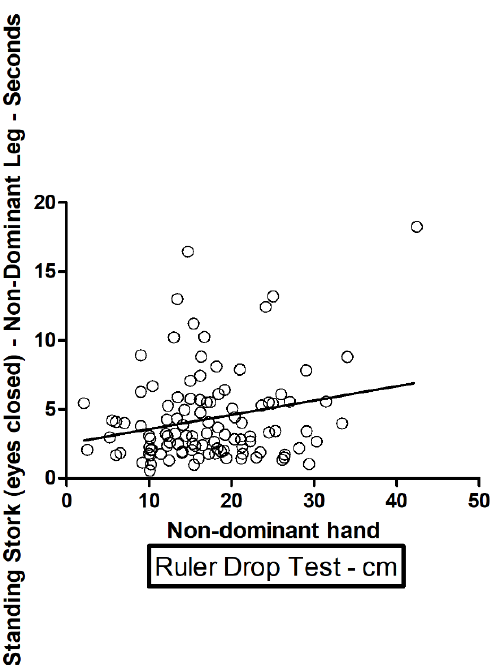
Figure 1. Standing stork (eyes closed) nondominant leg and nondominant hand.